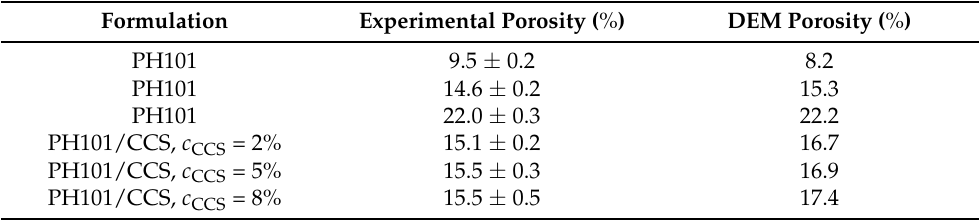
Table 8. Measured and simulated values of the tablet porosity for all conditions